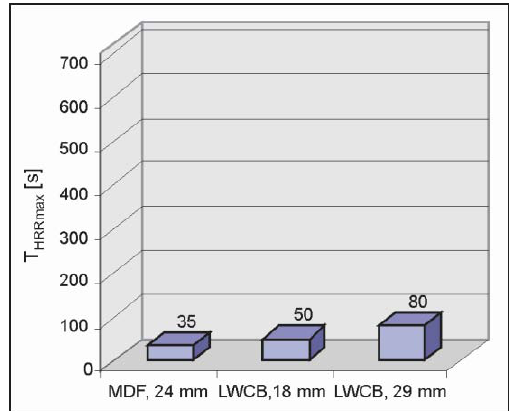
Fig. 10. Mean time to maximal heat release rate (T HRRmax ) when exposed to the surface heat flow density of 70 kW/m 2 for diffe- rent tested